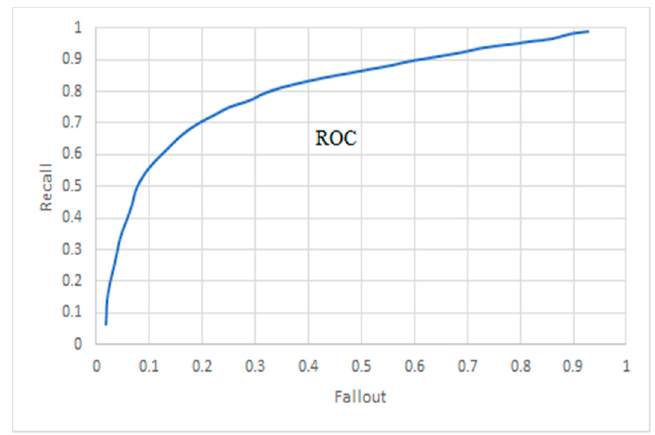
Figure 3. ROC (Receiver operating characteristic) curve for the recall against fallout.